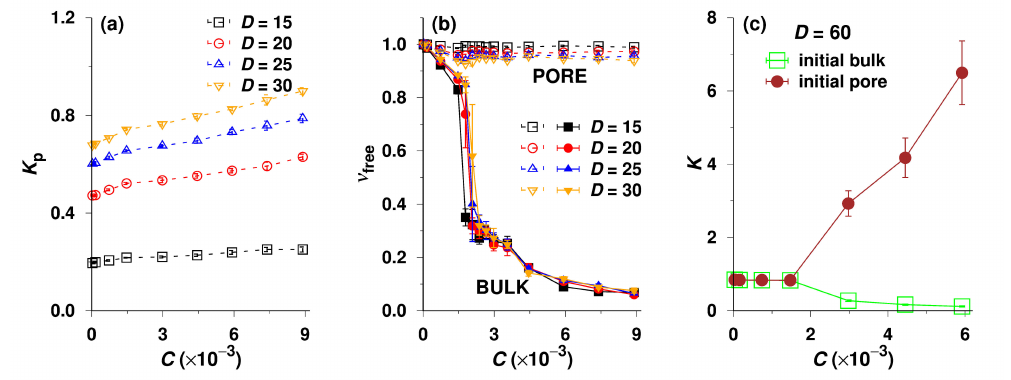
Figure 4. ( a ) Partition coefficient of non-associated A32B32 copolymers (unimers), K p , as a function of total concentration, C , for various pore diameters, i.e., D = 15, 20, 25 and 30. ( b ) Fraction of free chains, ν free , in both the bulk and the pore as a function of C for various D . ( c ) The effective partition coefficient, K , of A32B32 copolymers as a function of C for the wide pore of D = 60. The legends “init bulk” and “init pore” imply the two groups of simulations initially starting from the bulk and the pore,